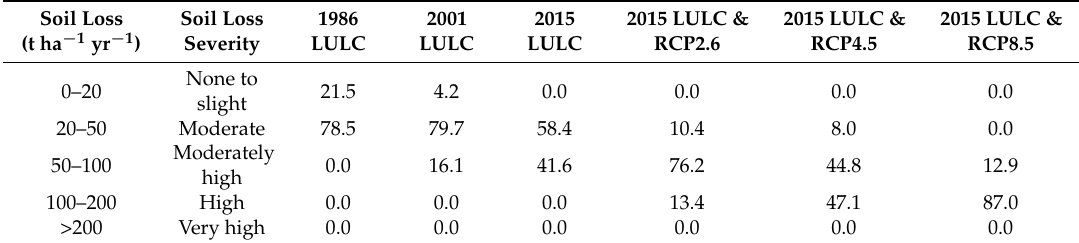
Table 11. Percentage proportions of areas in different soil loss severity classes under LULCC and climate change based on FAO soil loss category